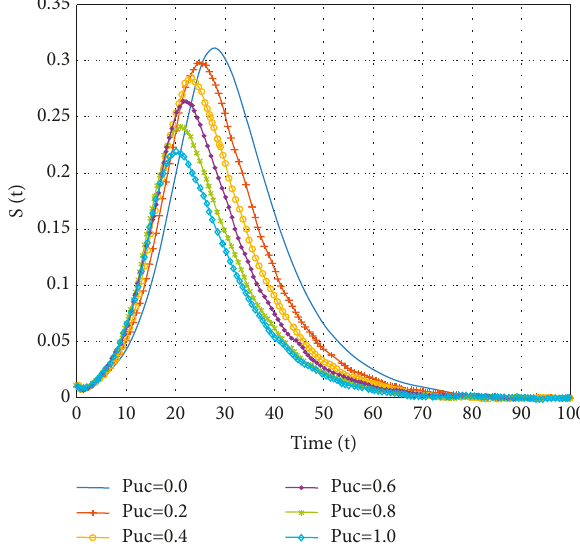
Figure 6: Effect of consensus probability on propagating and removed